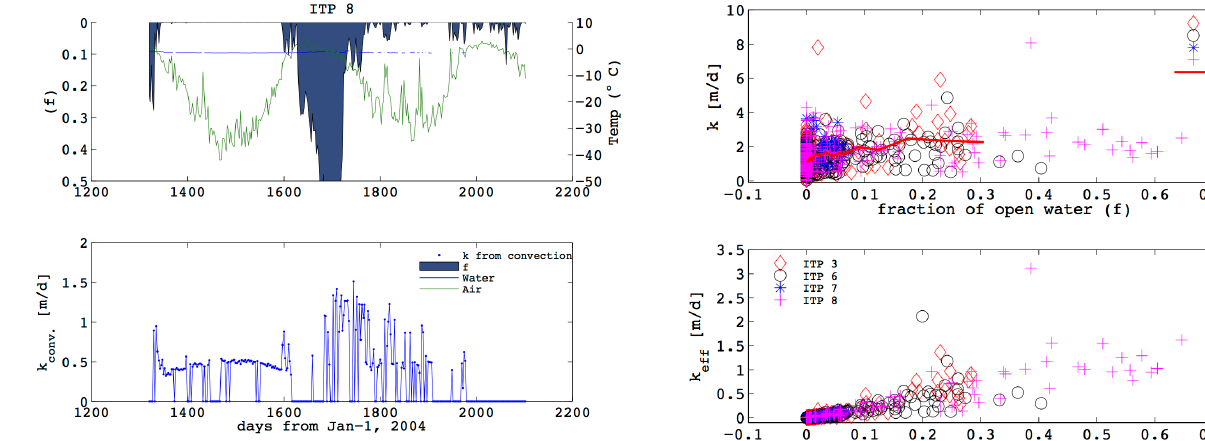
1 Figure 9. Top panel: The gas transfer velocity, k, from shear and convection in the sea ice zone, 2 Fig. 9. (top) The gas transfer velocity, k , from shear and convection graphed as a continuum with open water area, f. Bottom panel: The effective gas transfer 3 in the sea ice zone, graphed as a continuum with open water area, velocity, k eff , (equation 2) from shear and convection along the drift tracks of ITP 3, 6, 7, and 8. 4 f . (bottom) The effective gas transfer velocity, k eff , (Eq. 2) from 5 shear and convection along the drift tracks of ITP 3, 6, 7, and